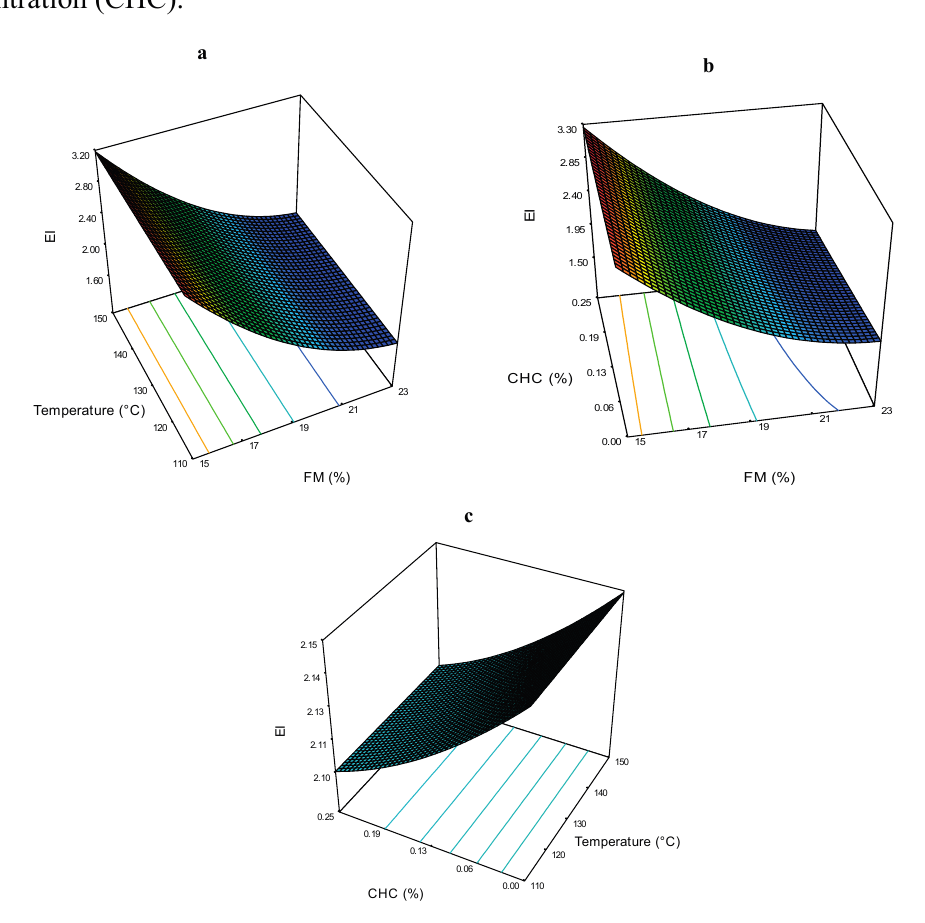
Figure 6. Expansion index (EI) of expanded nixtamalized blue corn extrudates, as a function of: ( a ) feed moisture (FM) and temperature (T); ( b ) feed moisture (FM) and calcium hydroxide concentration (CHC); and ( c ) temperature (T) and calcium hydroxide concentration